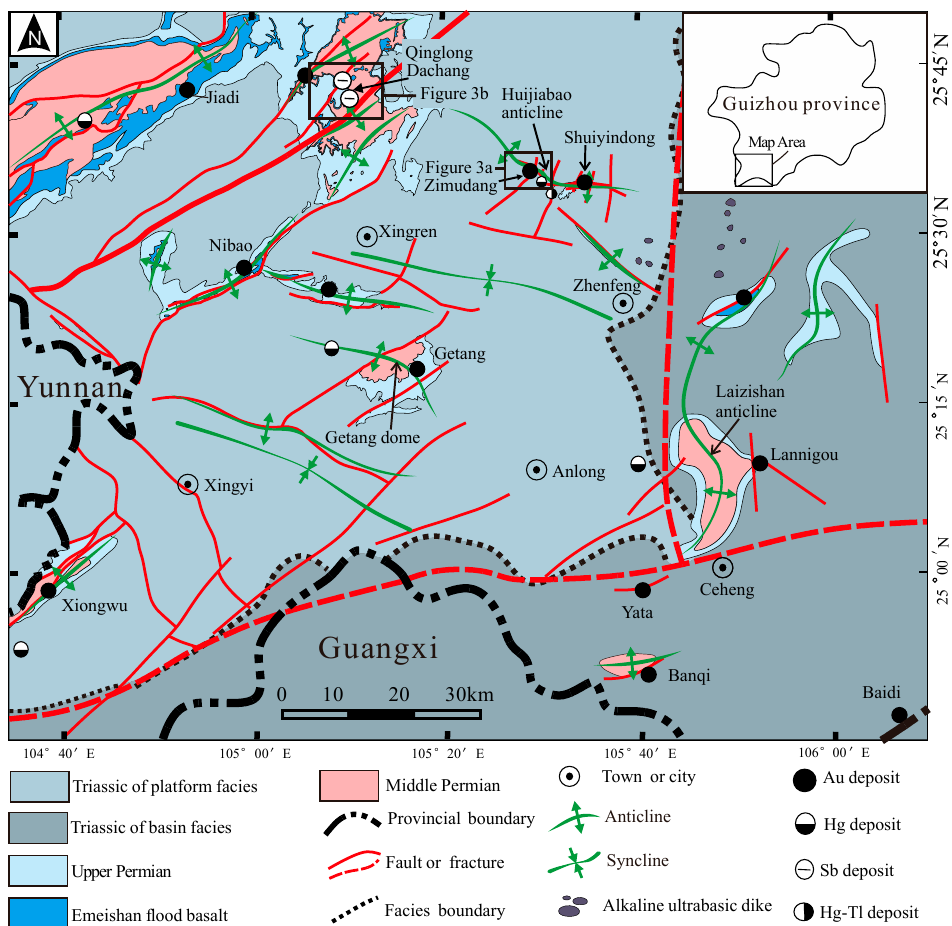
Figure 2. Geological map of Southwestern Guizhou showing the distributions of major Carlin-type Au, Sb, Hg, and Hg-Tl deposits.